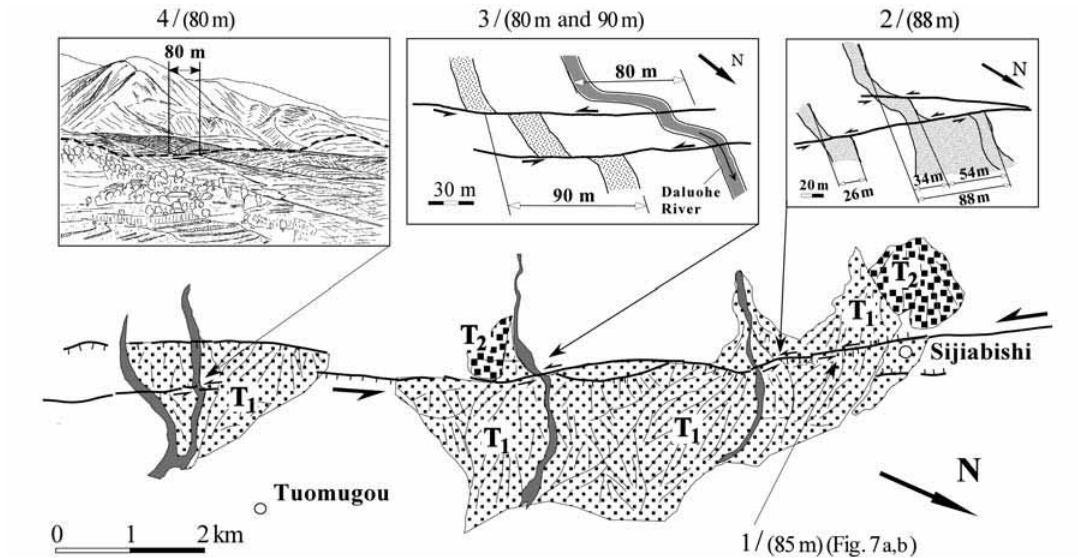
Fig. 11. Map showing the fault trace and terraces of the alluvial fan in the Zemuhe Valley between Sijiabushi and Tuomugou. Five offsets of streams developed on the alluvial fans of the first terrace (T red at four sites. Three boxes above show detailed offsets of